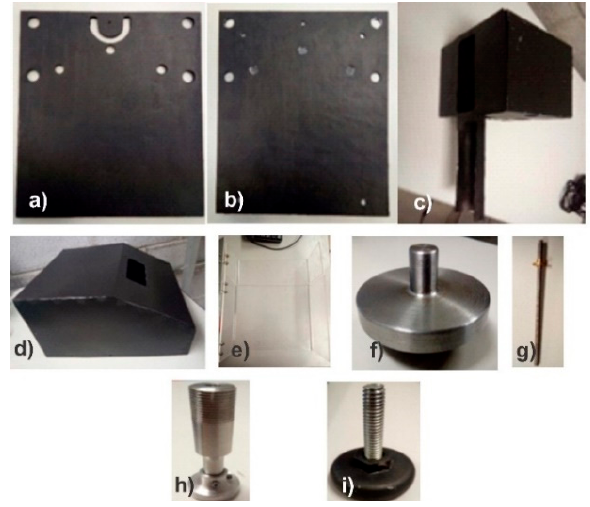
Figure 11. ( a ) and ( b ) Steel plates, ( c ) container box (the motor and electronic accessories), ( d ) sheet metal casing, ( e ) acrylic protective cover, ( f ) inertia flywheel, ( g ) threaded rod, ( h ) rotor (shaft ant tip), ( i ) adjustable leg leveler.